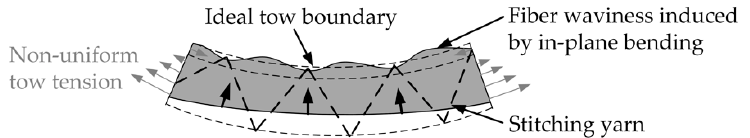
Figure 21. Schematic illustration of fiber waviness induced by zig-zag stitches in tailored fiber placement (TFP) process; adapted from [60].